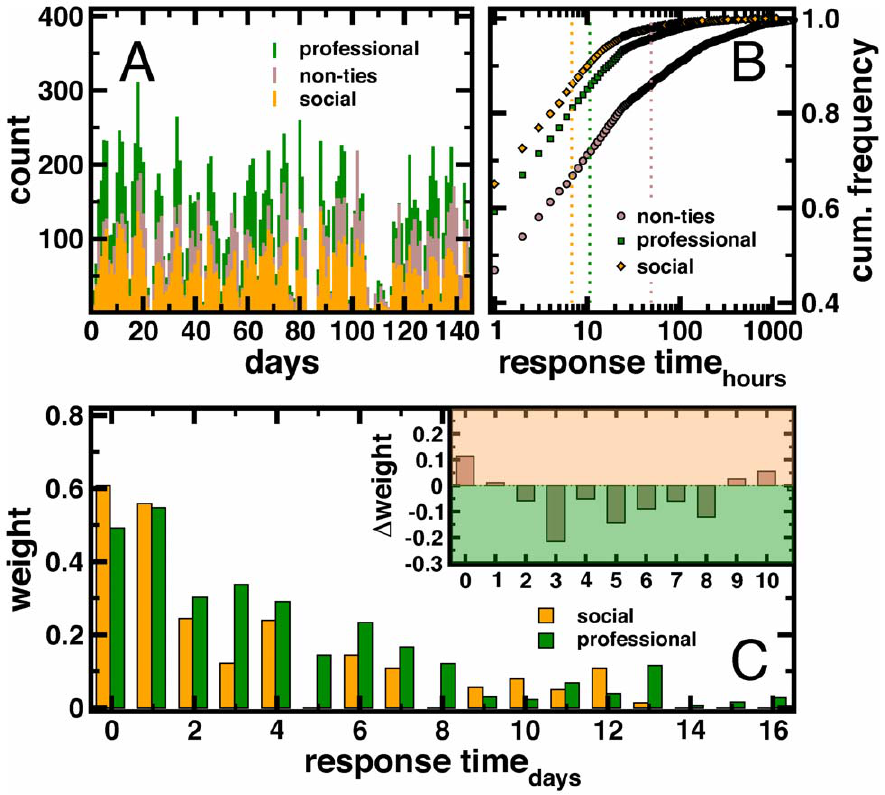
Figure 3. Time-resolved data characteristics. In ( A ) we show a profile of emails that were exchanged along social and professional ties. Non-ties referred to pairs of individuals that exchanged emails but were not self-reported as contacts. ( B ) Frequency distributions of response times (mean = dotted lines) of different types of ties indicate that social friendship ties had the lowest response time. ( C ) Discriminating between self-reported ties and non-ties using the normalization method, we determined the weight of emails that were exchanged in a certain time interval. We observed that emails sent within the same day contributed significantly to the discrimination of social and professional ties from non-ties. Determining weight difference, emails exchanged in short intervals predominantly characterize social friendship ties while emails that were sent with up to 8 days delay had a higher impact on the discrimination of professional ties (inset).